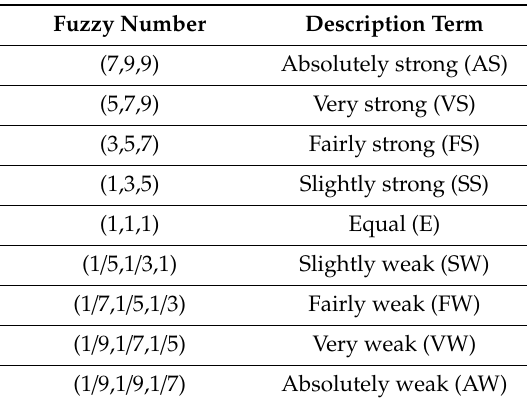
Table 1. Fuzzy spectrum for comparison of risk assessment